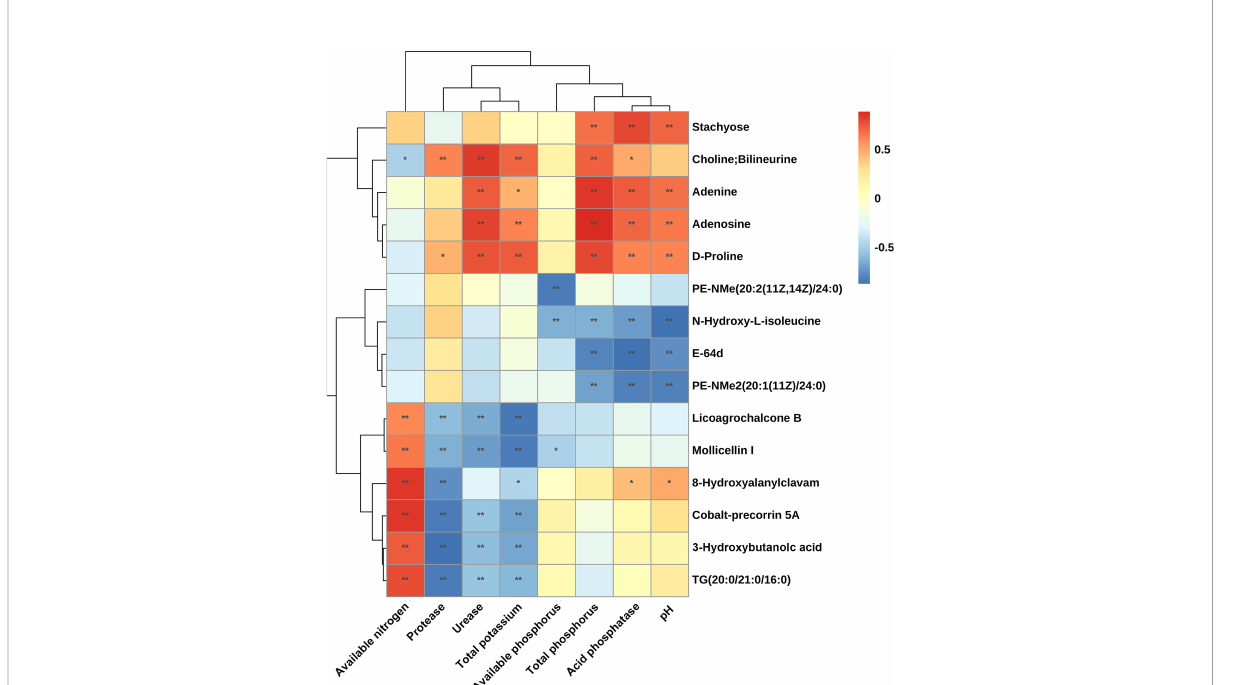
FIGURE 7 Spearman ’ s correlations of signi fi cant differential metabolites from rhizosphere soils and rhizosphere soil physicochemical properties. Signi fi cance between metabolites and physicochemical properties: *, P ≤ 0.05, **, P ≤ 0.01. The fi gure was plotted based on six repeated values of physicochemical properties of rhizosphere soil and six repeated values of metabolite